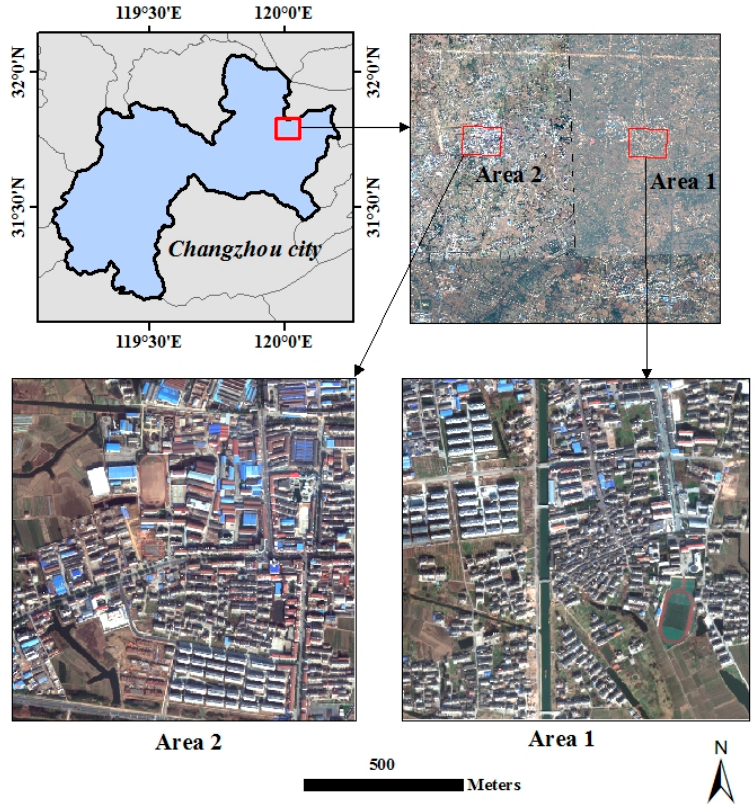
Figure 1. The two study areas located within the city of Changzhou, China.